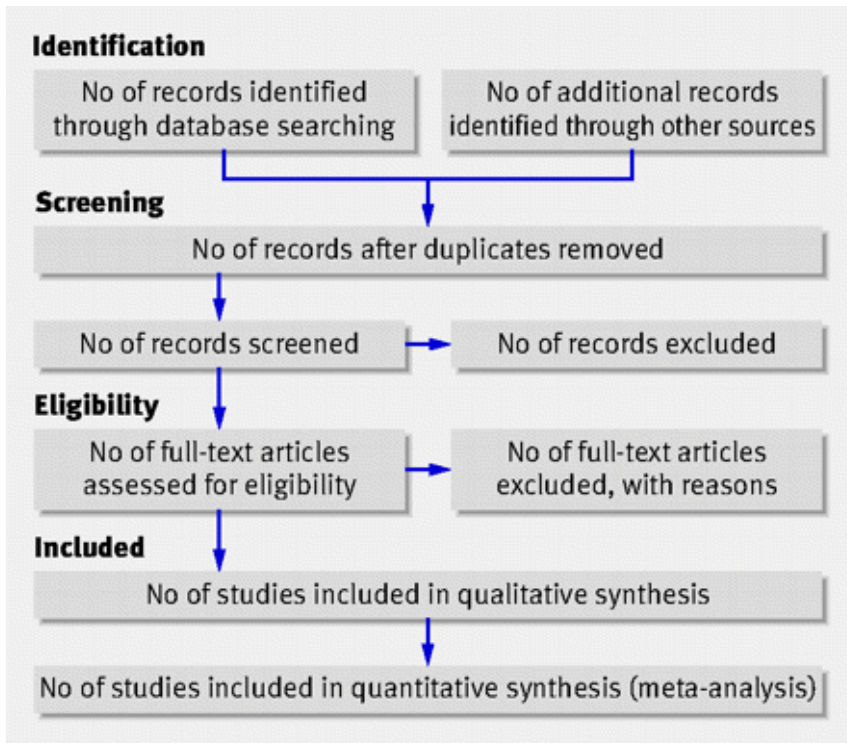
Figure 1. Template for a graphical representation of the literature review process, taken from [1].